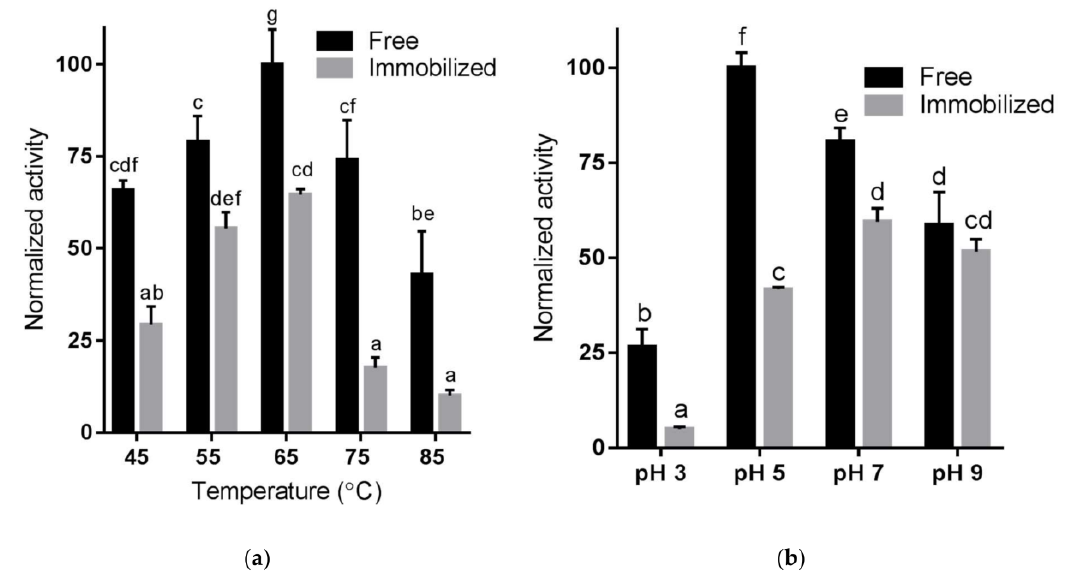
Figure 4. Mean relative activity of free and immobilized enzyme at different ( a ) temperature and ( b ) pH values using RNase B. Error bars represent one standard deviation and means, within the same chart, followed by different letters (a, b, c, d, e, and f) are statistically different at p < 0.05.